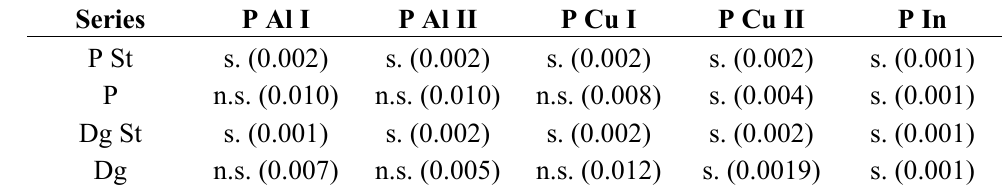
Table 6. Statistical tests of the R Z values of all implanted and non-implanted test series (s = significant, ns = not significant); p -values.